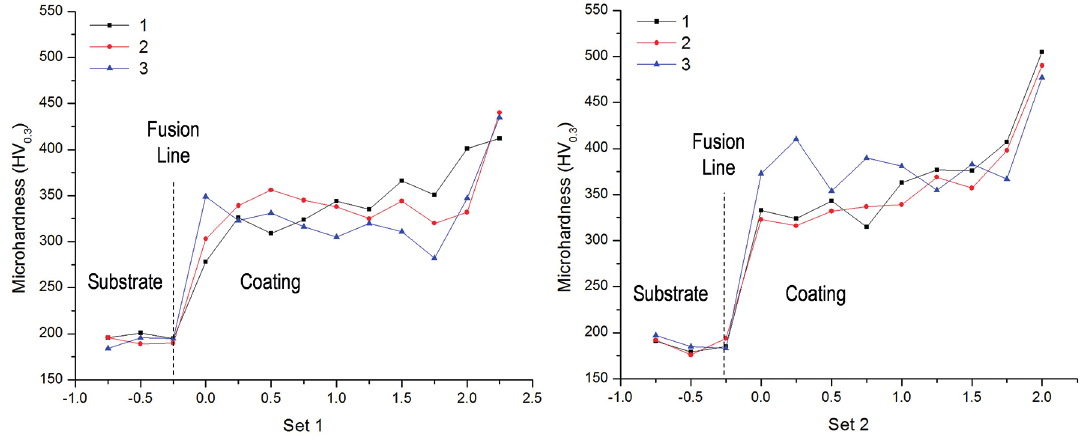
Figure 6: Vickers microhardness profile on the cross-section of CWHS specimens, showing a hardness increase towards the surface. Results on Table 2 show that the nominal incubation work deformation also contributed to a reduction in the time increases on deformed surfaces, in other words that maximum erosion rate, which is in accordance with the the onset of the maximum erosion rate is delayed. Cold literature 11, 12 . The cold-work hardening decreased